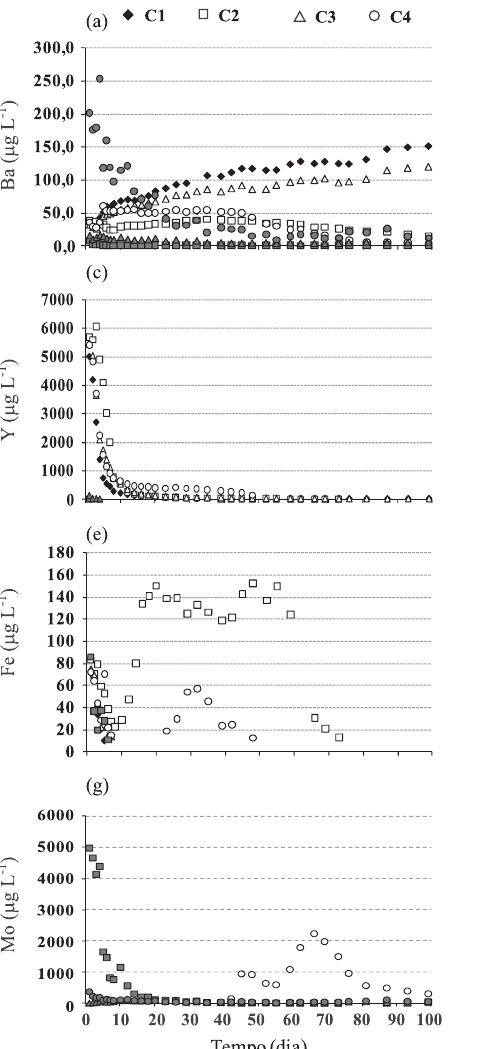
Figura 5. variações de elementos-traço (ba, sr, y, Zr, Fe, U, mo e v) nas águas lixiviadas ao longo do